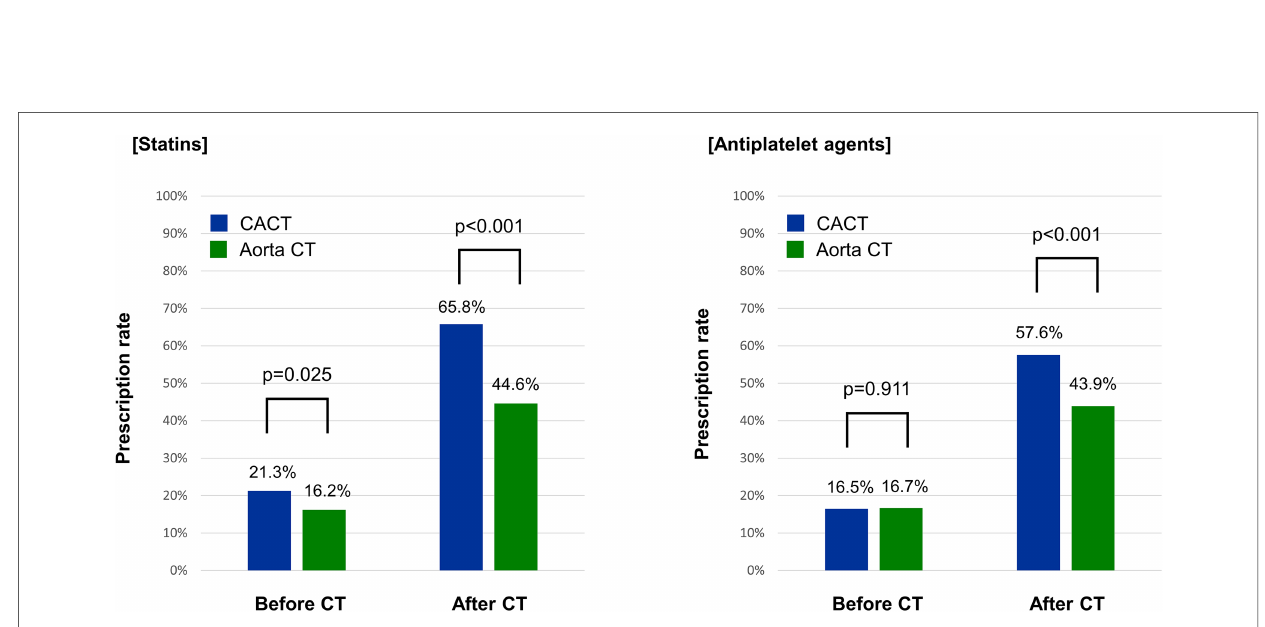
FIGURE 1 Patterns of invasive CAG and timing of coronary revascularization after CT scan. Left panels describe the proportions of diagnostic only CAG and coronary revascularization among total invasive CAG after CT scan. Right panels describe the timing of coronary revascularization after CT scan. Aorta CT, thoracoabdominal aorta CT angiography protocol; CACT, coronary-aorta CT protocol; CAG, coronary angiography; CT, computed tomography; mo, month.